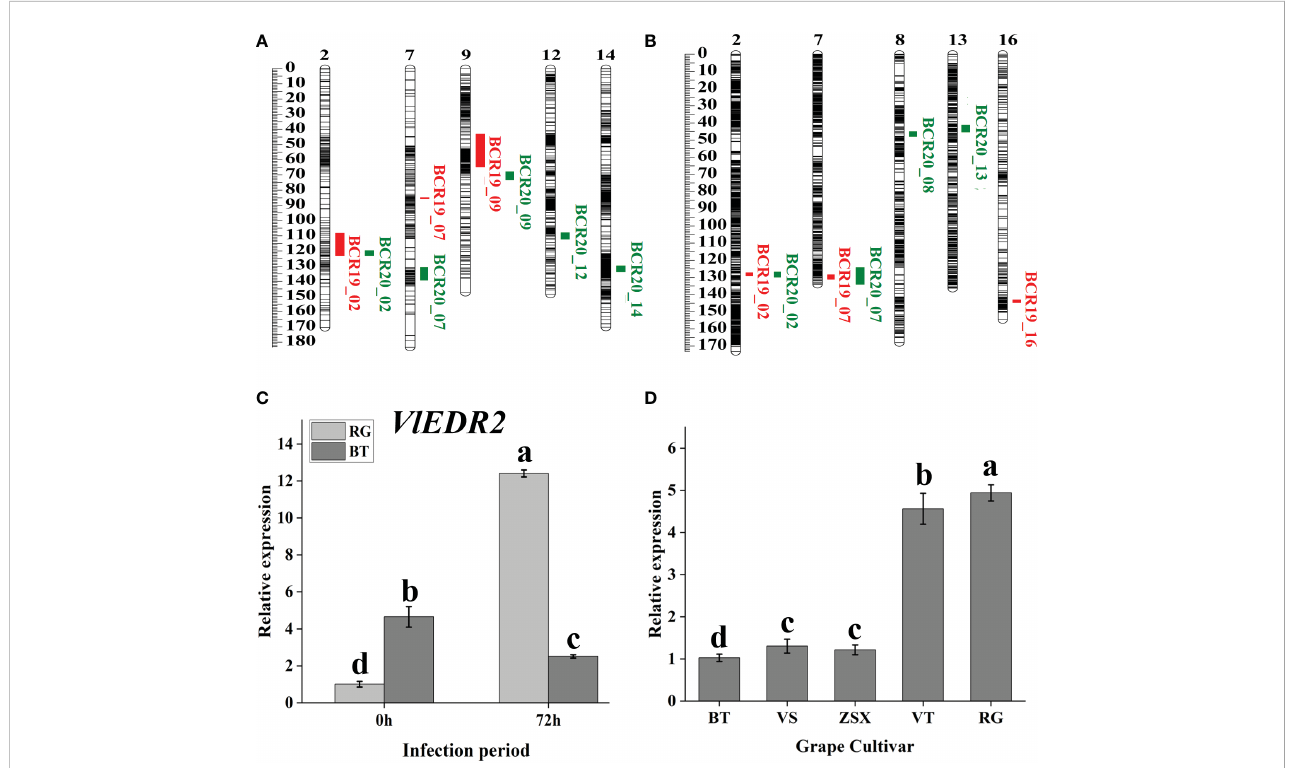
FIGURE 3 Candidate gray mold resistance gene discovery based on QTL mapping. (A, B) Gray mold resistance QTL mapping based on the hybrid population ‘ ZSX ’ × ‘ VT ’ and ‘ RG ’ × ‘ VS ’ . (C) Cluster heat map of gene expression involved in the common interval of stable QTL. (D) qRT-PCR analysis of candidate gray mold resistance gene VlEDR2 at different infection periods. Light-gray bars represent cultivar ‘ RG, ’ and dark-gray bars represent cultivar ‘ BT. ’ Error bars represent the standard deviation of three biological replicates. Lowercase letters on the bar chart represent signi fi cant differences between the two cultivars and different developmental stages according to Duncan ’ s multiple range test at P <